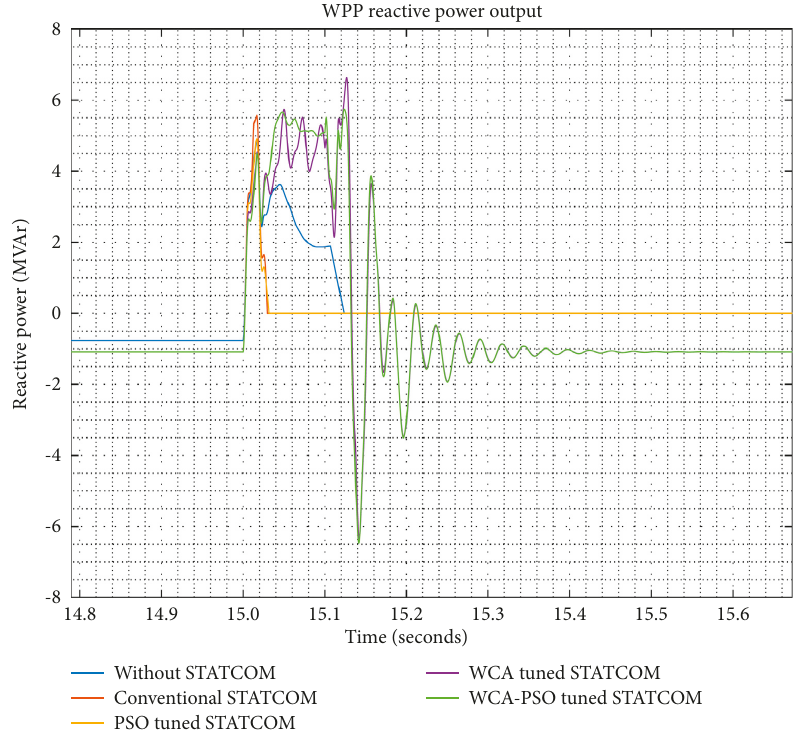
Figure 16: WPP reactive power output.